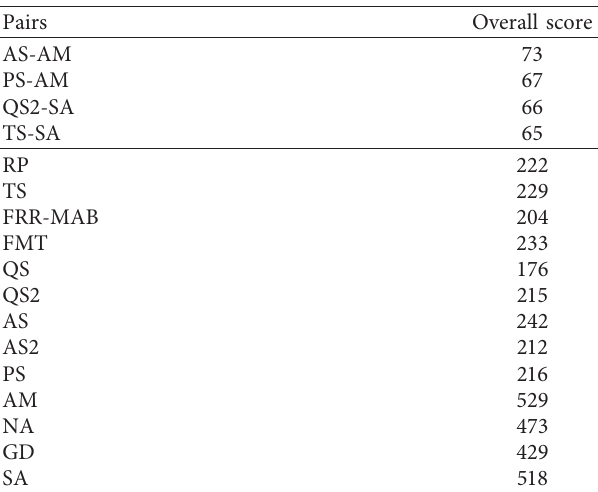
Table 3: The overall formula (1) scores for the top four pairs and